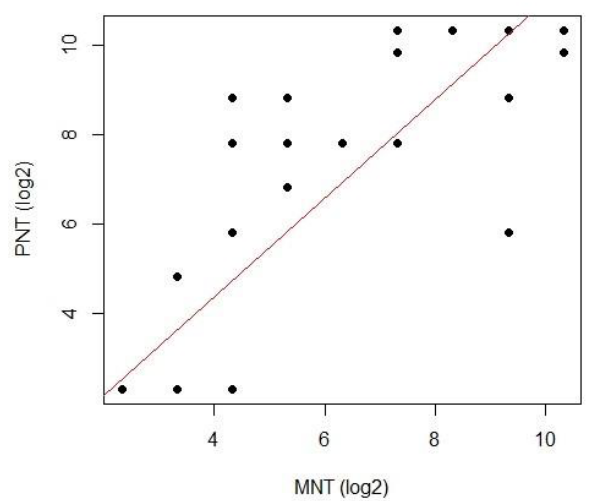
Figure 5. PNT vs. MNT relationship. The scatterplot of the MNT ( x -axis) and PNT ( y -axis) presented a linear pattern.